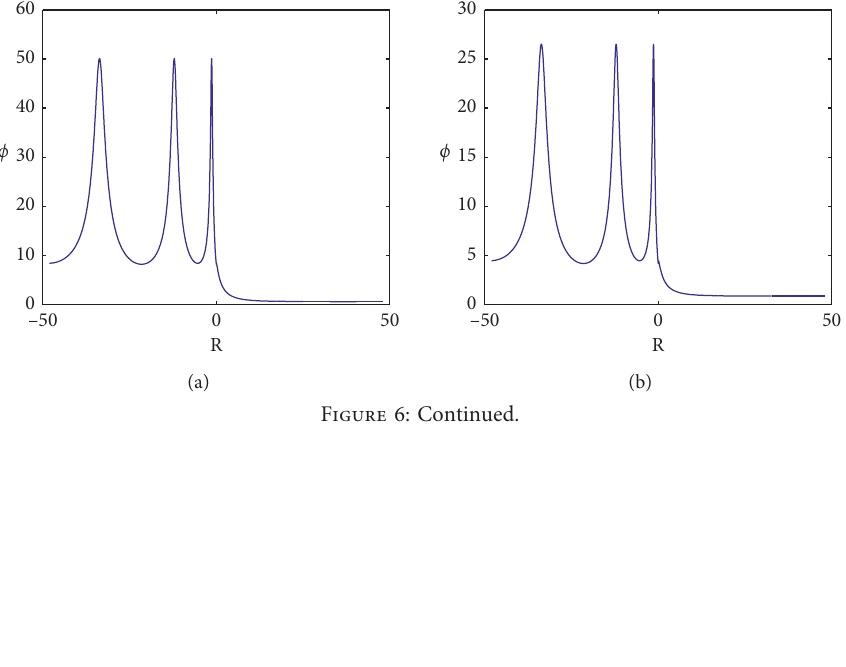
� 1 . 2, β � 1 . 4, λ � 1 . 3, ω � 1, and ϖ � 1. (d) β 1 3